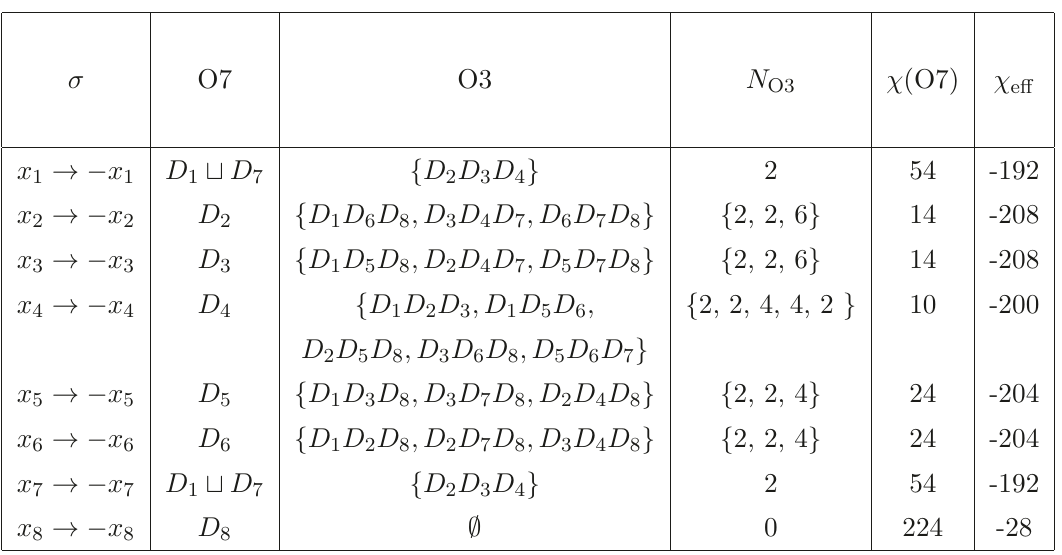
Table 6 . Fixed point set for the involutions which are reflections of the eight coordinates x i = 1 , . . . ,